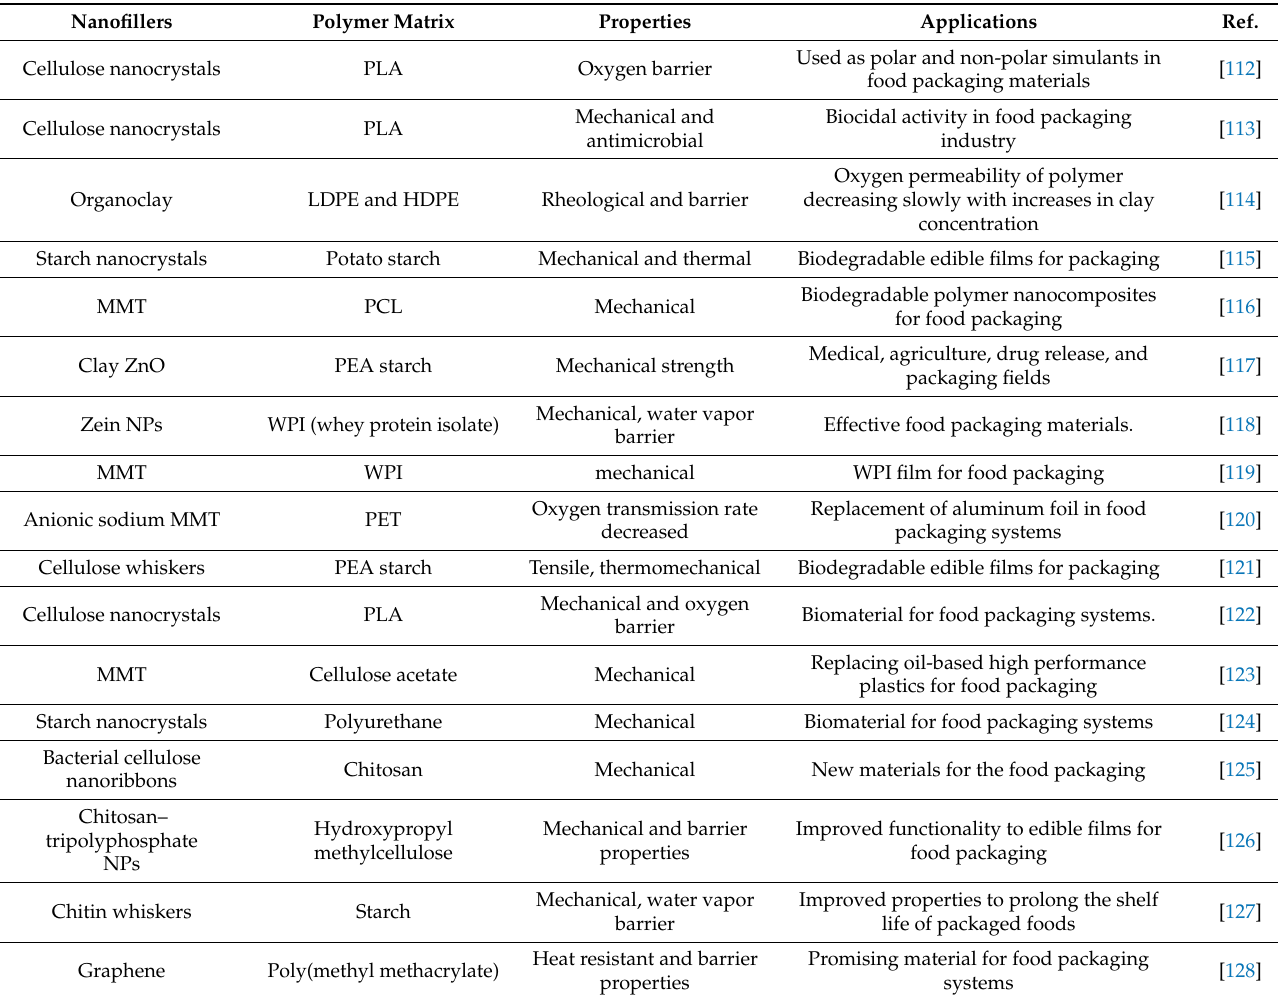
Table 2. Examples of nanofillers and polymer matrices that have been applied as nanocomposites in food packaging systems.